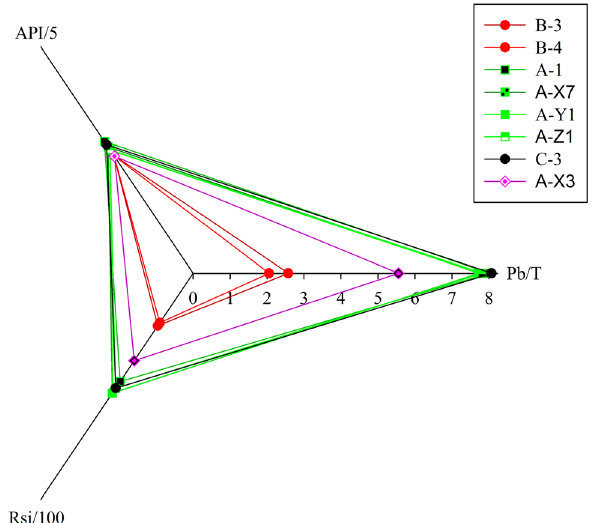
Fig. 12 Comparison of bulk oil properties of the three fields. The oil properties in each field are identical. There is a trend in oil properties from Fields A and C through Field B. The oil in Well A-X3 which is drilled in the bridge between Fields A and B bears average properties of oils in Fields A and